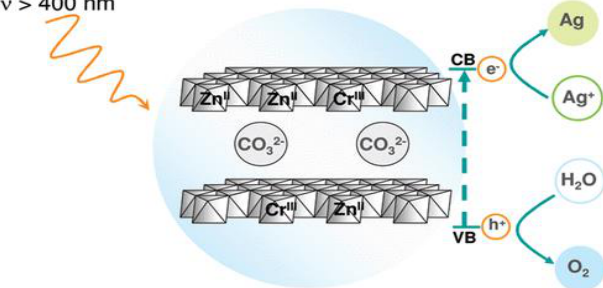
Figure 6. Water splinting by mixed metallic LDHs ‘’Reprinted with permission from Ref. [82]. 2009, American Chemical Society.’’ .